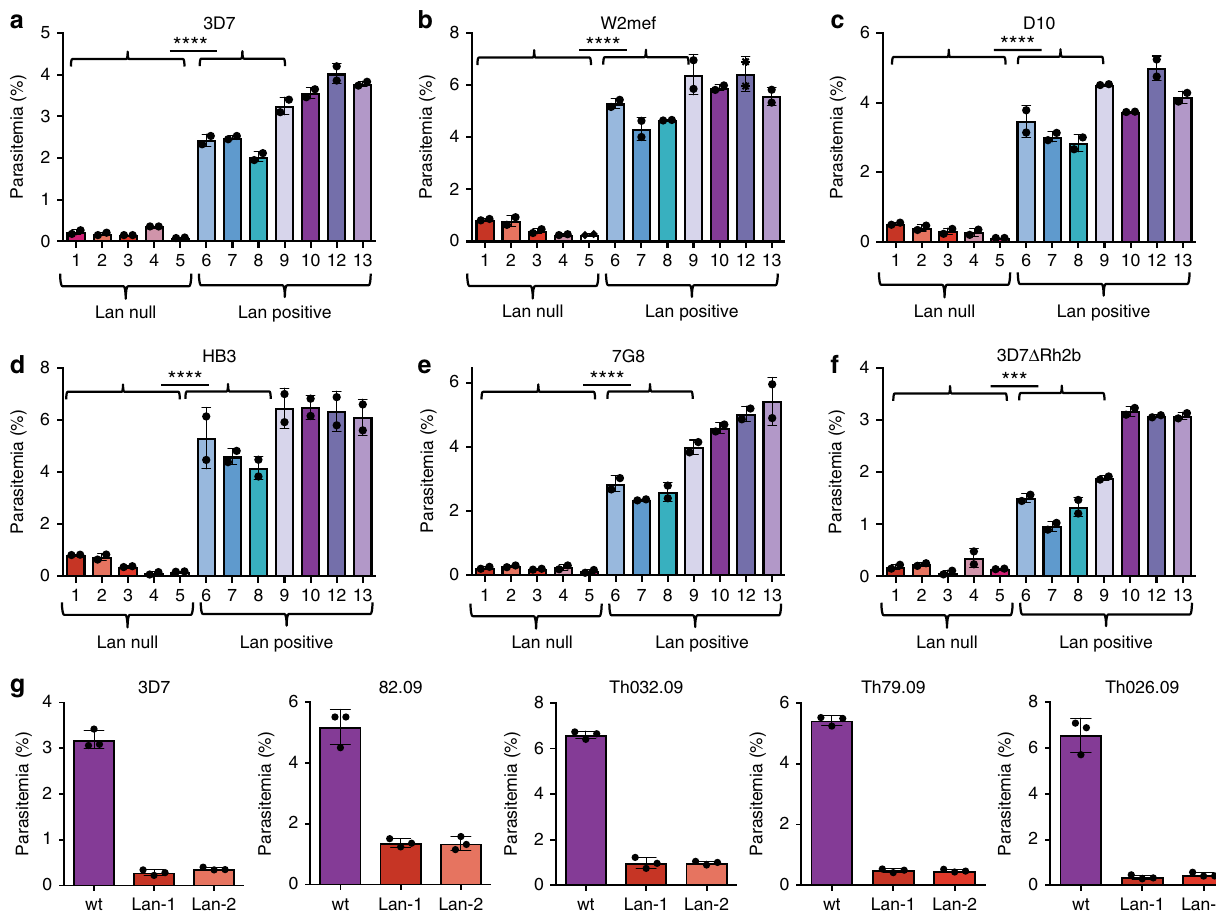
Fig. 2 Impaired P. falciparum invasion into Lan-negative erythrocytes is independent of Lan null genotype, and is strain-transcendent. a Comparison of invasion by P. falciparum strain 3D7 into erythrocytes from fi ve unrelated Lan null individuals (#1 – 5; see Table 1 for details of samples) and seven Lan- positive control individuals (#6 – 10 and 12 – 13), which serve as biological replicates. Samples 1 – 9 were previously cryopreserved and thawed, and samples 10,12, and13 were fresh. b – f Invasion by fi ve additional P. falciparum strains (W2mef, D10, HB3, 7G8, and 3D7 Δ Rh2B, respectively). Invasion was measured by SYBR green I staining and fl ow cytometry. Values are expressed as mean parasitemia ±SD, n = 2. **** p ≤ 0.0001, *** p = 0.0002, two-tailed t -tests. g Invasion by P. falciparum strain 3D7 or four clinical isolates from malaria patients in Senegal (82.09. Th032.09, Th79.09, and Th026.09) into Lan null or Lan-positive erythrocytes. Invasion was measured by SYBR green I staining and fl ow cytometry. Values are expressed as mean parasitemia ±SD, n =